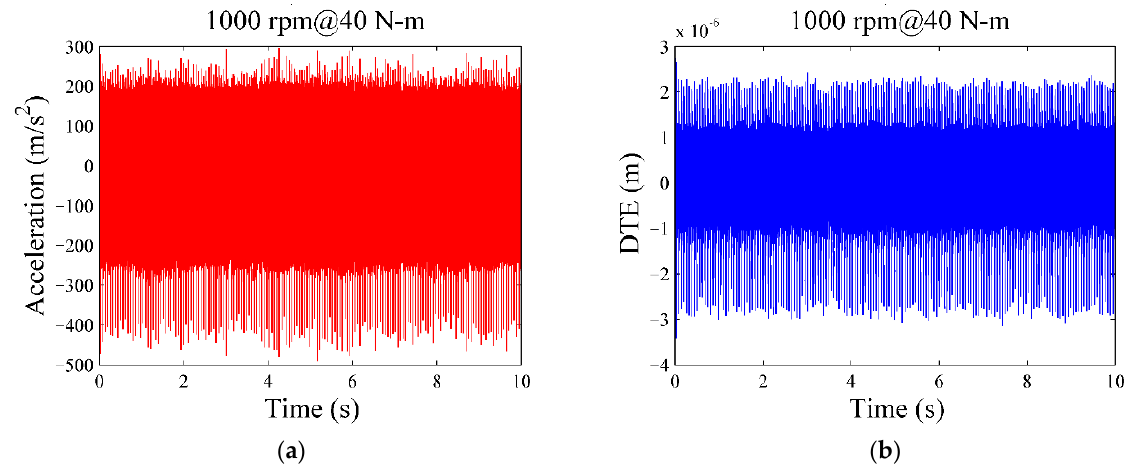
Figure 10. Experimental signal in the time domain: ( a ) acceleration; ( b ) DTE.